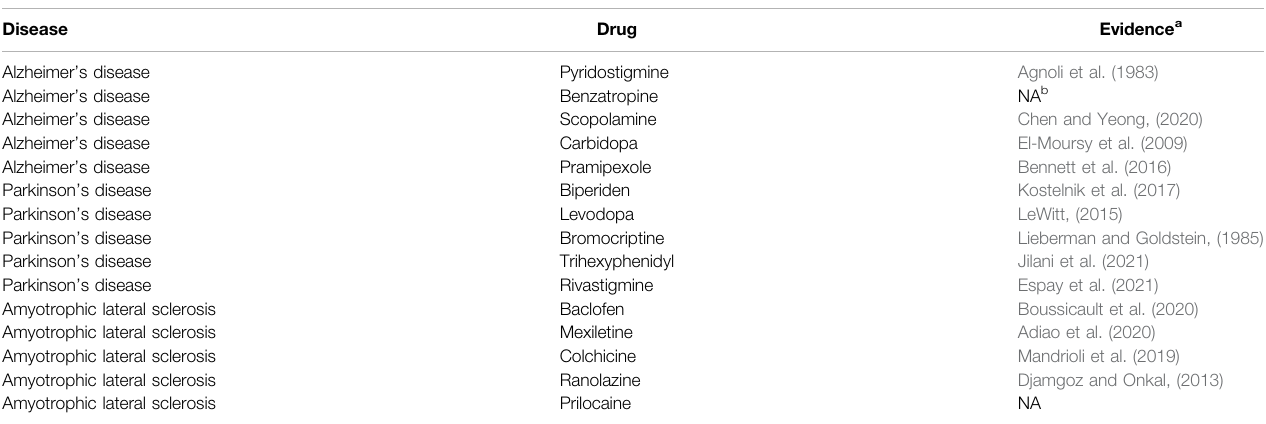
TABLE 5 | Top fi ve candidate drugs for complex diseases.